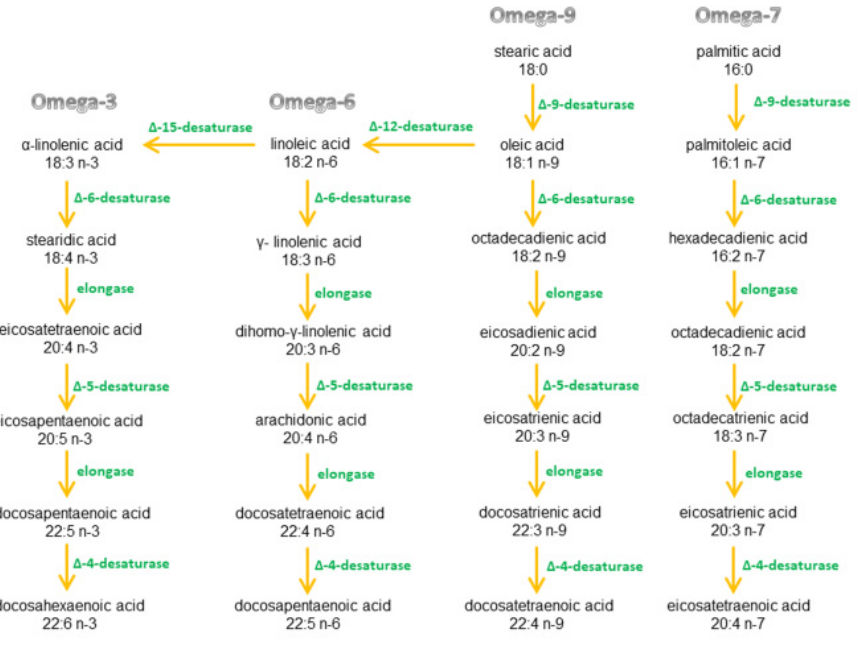
Figure 5. Fatty acid metabolism.